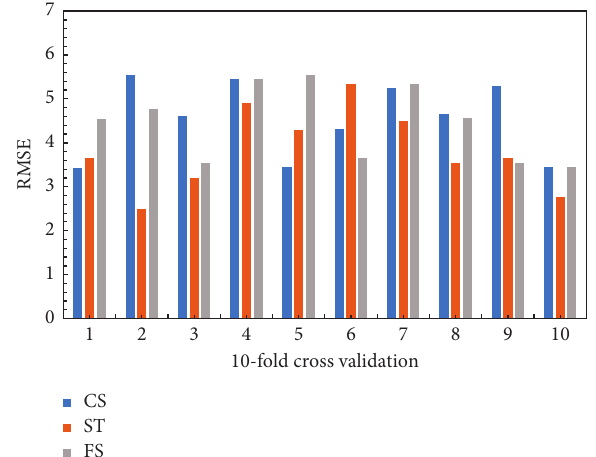
Figure 9: Cross validation results of CS, ST, and FS models based on RMSE.